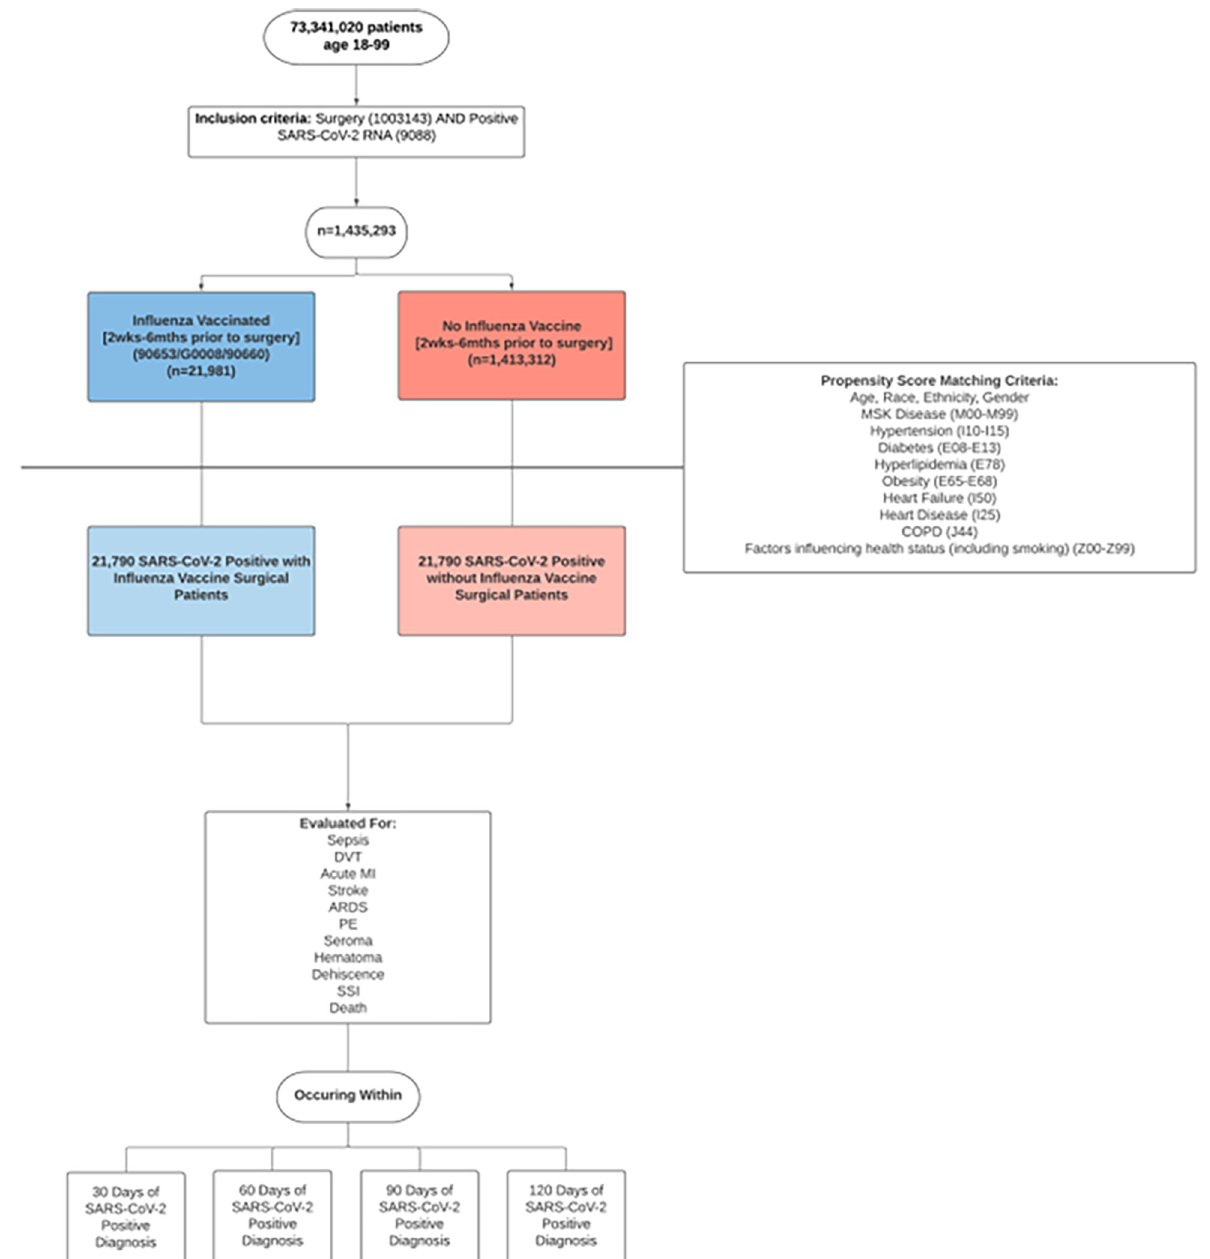
Fig 1. Study design, illustrating methodology and inclusion criteria. Two equally balanced cohorts of 21,790 created using propensity score matching. Various adverse outcomes were analyzed and compared between the influenza vaccinated and non-influenza vaccinated cohorts.